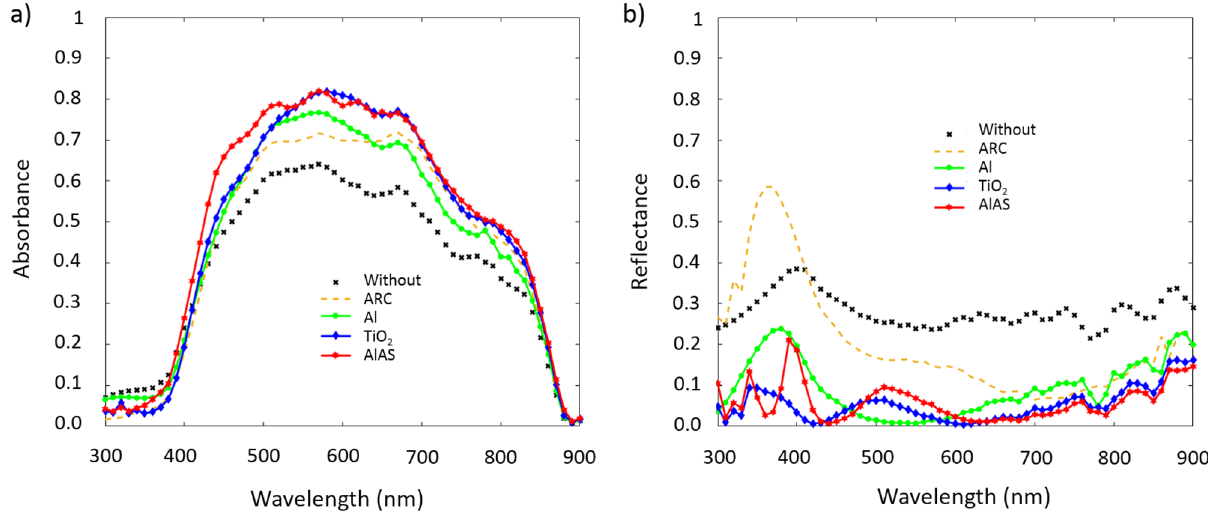
Figure 2. Spectral evolution of ( a ) the absorbance in the active layer and ( b ) the total reflectance of a GaAs solar cell for five different configurations: a conventional device without photonic strategies, a solar cell including an antireflection coating, a device with aluminum plasmonic nanoparticle on top of it and a solar cell including dielectric nanoparticle on it (TiO 2 or